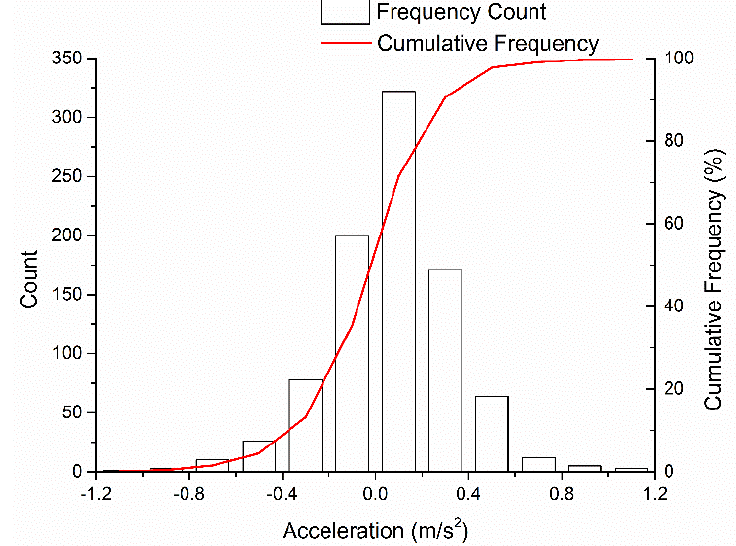
Figure 9. Acceleration distribution .